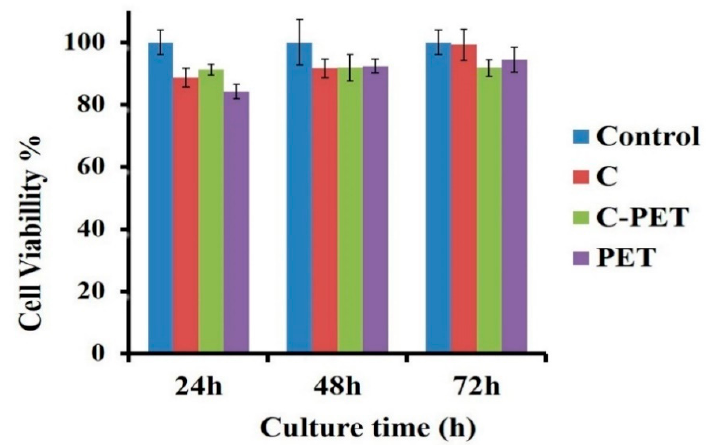
Figure 7. Proliferation profiles of cells grown on electrospun samples up to three days.